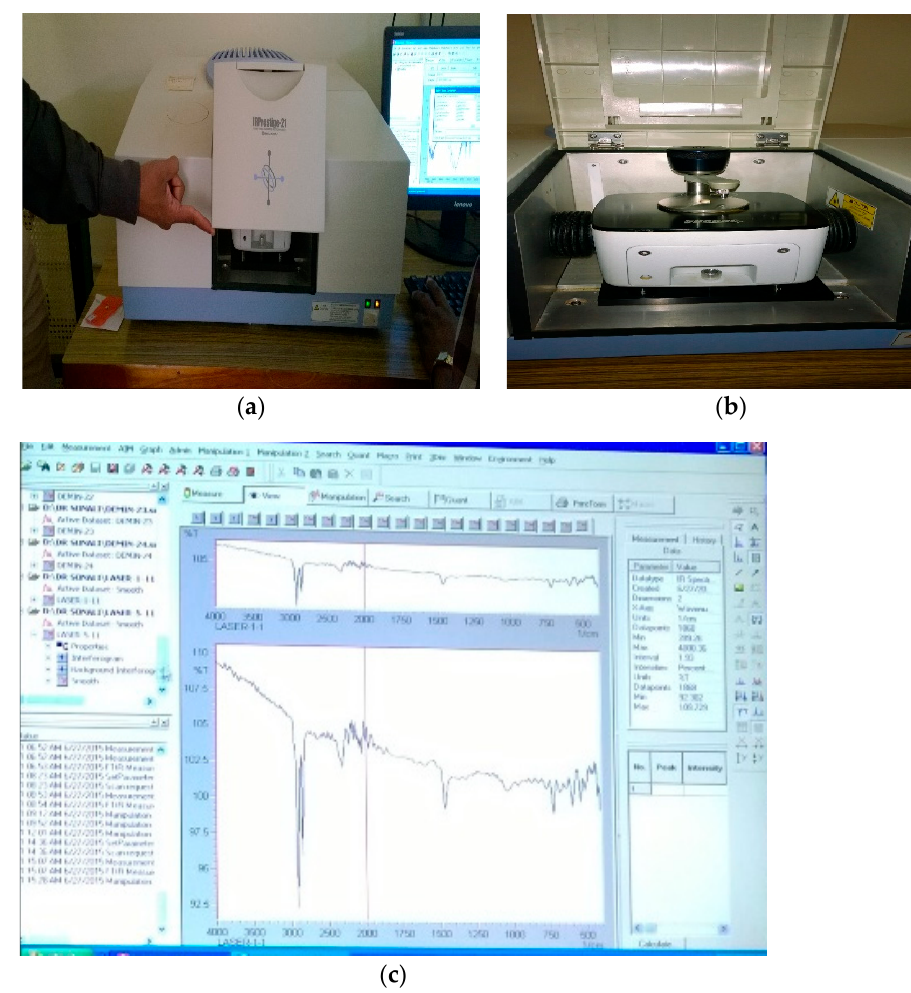
Figure 1. ( a ) FTIR spectroscopy equipment. ( b ) FTIR spectroscopy analysis being carried out on enamel sample. ( c ) FTIR analysis of enamel samples being carried out.